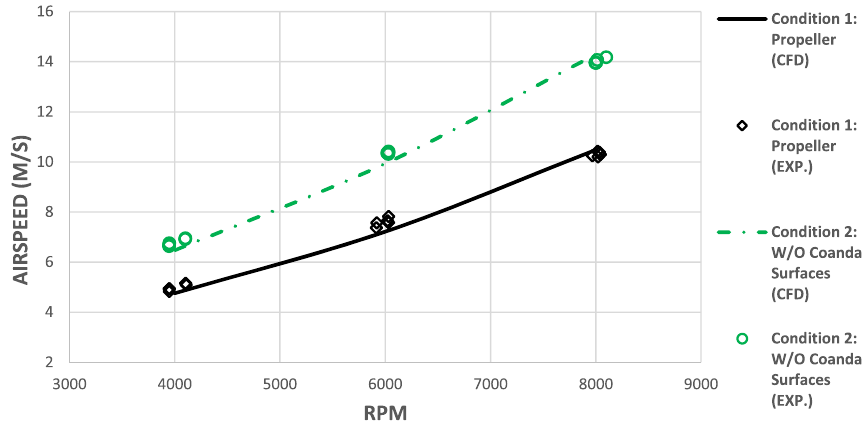
Fig. 8 Airspeed vs RPM results for loading conditions 1 and 2